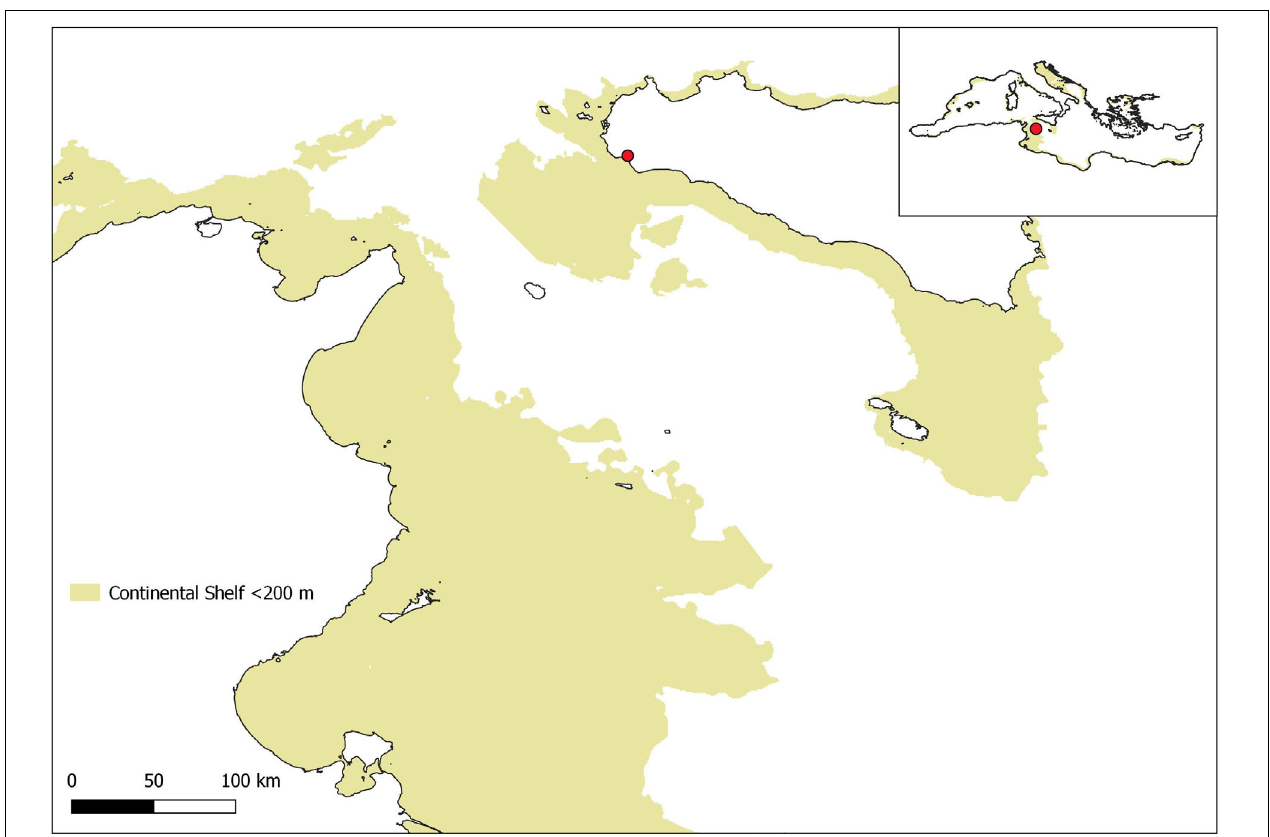
Figure 4 . Most of the observations were located in different fishing grounds of the continental shelf of Tunisia and Libya, whilst only a few records include the Sicilian shelf.